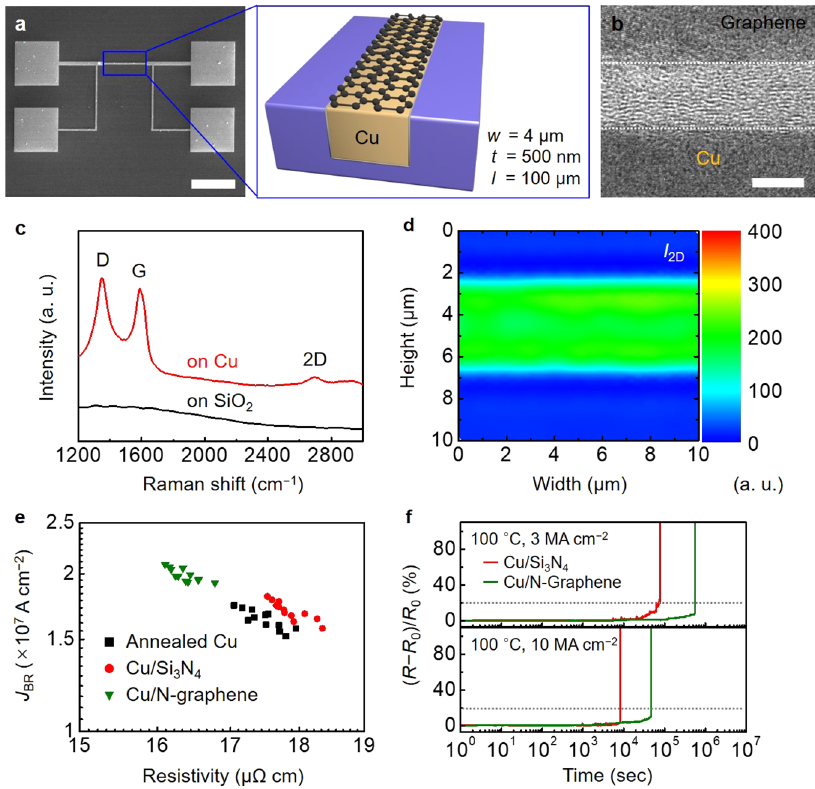
Fig. 4 Characteristics of the damascene-patterned Cu-graphene interconnects. a SEM and schematic images of Cu/N-graphene interconnect with damascene-patterned structure. b HRTEM image of N-doped graphene synthesized on the damascene-patterned Cu interconnect using pyridine by APCVD at 400 °C. c Raman spectra of damascene-patterned Cu interconnects measured on Cu surface and SiO 2 of substrate after graphene synthesis d Raman mapping image of N-doped graphene synthesized on damascene-patterned Cu interconnect. e J BR vs ρ plots of annealed Cu, Cu/Si 3 N 4 , and Cu/N-graphene interconnects. f ( R − R 0 )/ R 0 vs time of Cu/Si 3 N 4 and Cu/N-graphene interconnects measured at 100 °C under 3 and 10 MA cm − 2 . Scale bars, 100 µm in a , 5 nm in b